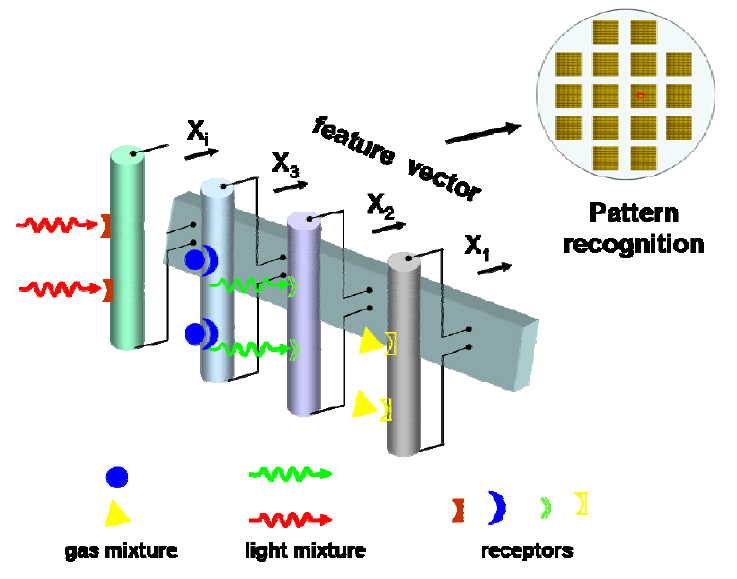
Figure 11. A sketch of a nanowire-based multi-functional detector